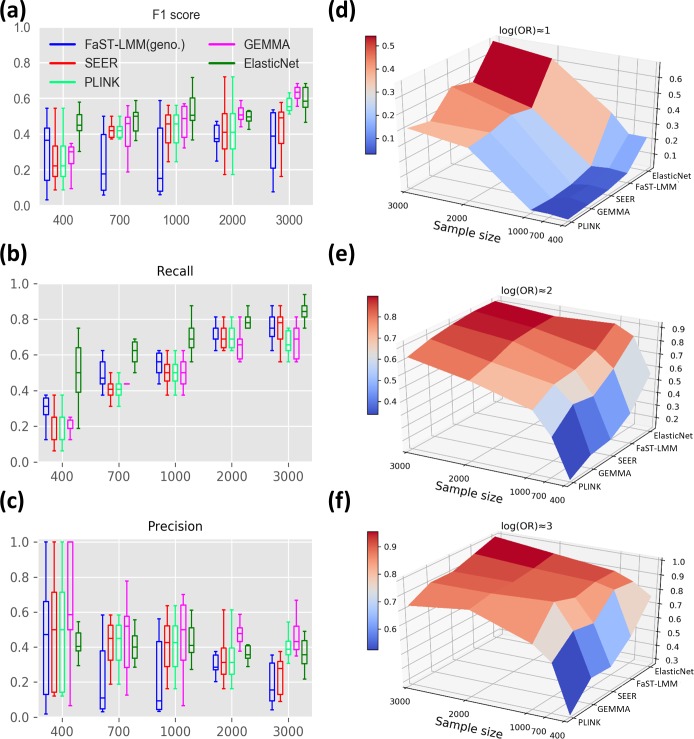
Performance of GWAS methods in simulations with low LD. (a, b, c) The boxplots on the left show the median and interquartile range, averaged across a range of effect sizes over ten replicates in each scenario (log OR=1 to 3). (a) F1 score of bacterial GWAS methods across a range of sample sizes under low LD. (b) Recall rates across the range of sample sizes. (c) Precision rates across the range of sample sizes. (d, e, f) The surface plots on the right show recall rates in separate categories of effect sizes.